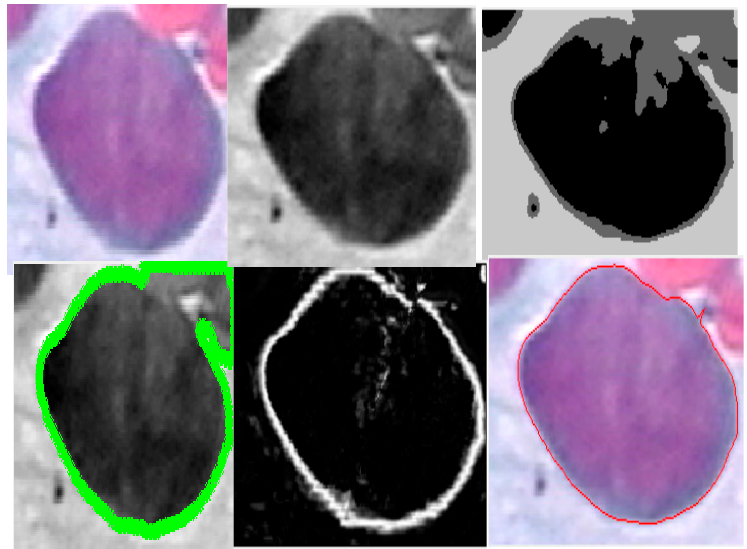
Figure 2. From left to right images represents the moderate dysplasia cell from the Herlev database, where the segmentation of nucleus and cytoplasm regions is performed using the simple iterative clustering initially, where the regions are separated, an optimized GrabCut is used for the hyper pixels generation with a Gaussian mixture model, and finally, the Bayes classifier is used to identify the nucleus and cytoplasm regions, where the dark intensity regions are represented as a nucleus and the boundary marked in red is identified as cytoplasm.